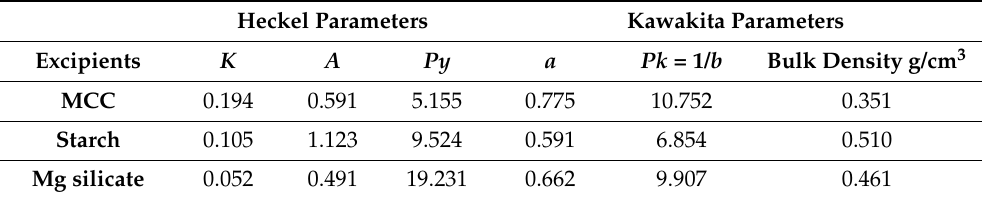
Table 3. Heckel parameters for MCC, starch, and Mg silicate as single components. Heckel Parameters Kawakita Parameters Excipients K A Py